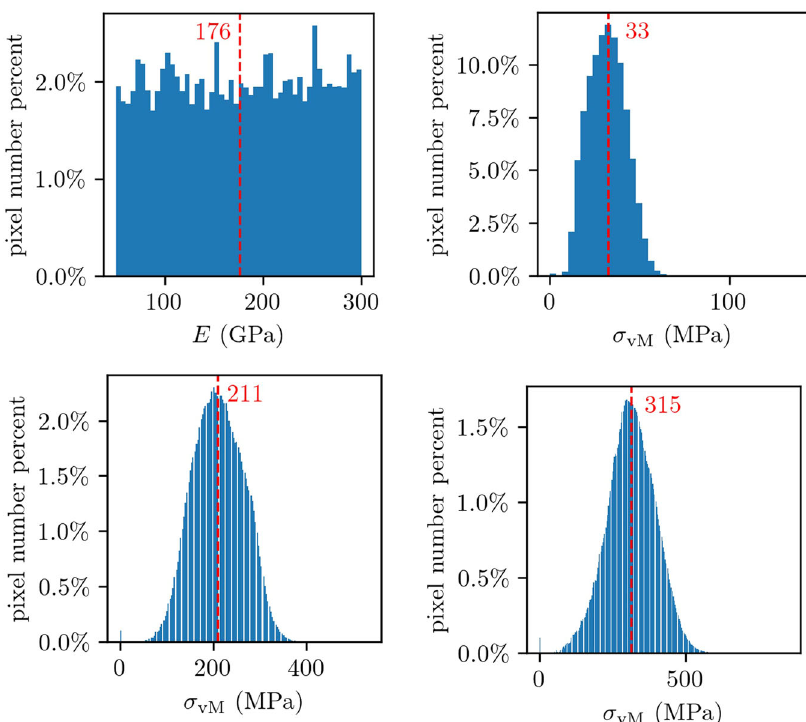
Fig. 11 Distributions of values and corresponding mean value (in red) for selected input quantities in the training data. Top left: Young ’ s modulus E . Top right: σ RM for F 11 ¼ 1 : 001 . Bottom left: σ RM for F 11 ¼ 1 : 002 . Bottom right: σ RM for F 11 ¼ 1 : 004 .